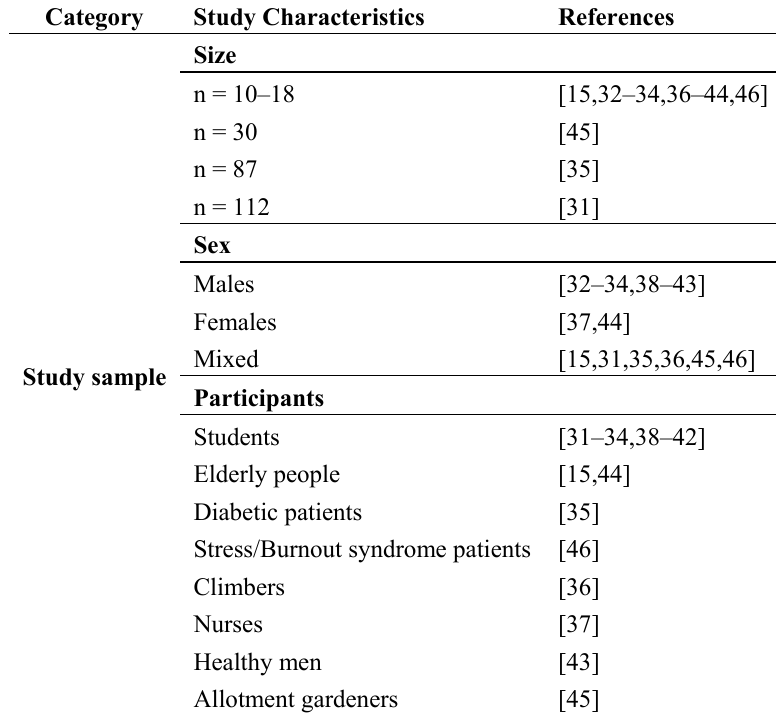
Table 2. Description of study characteristics of reviewed article (n = 17) stratified by methodological